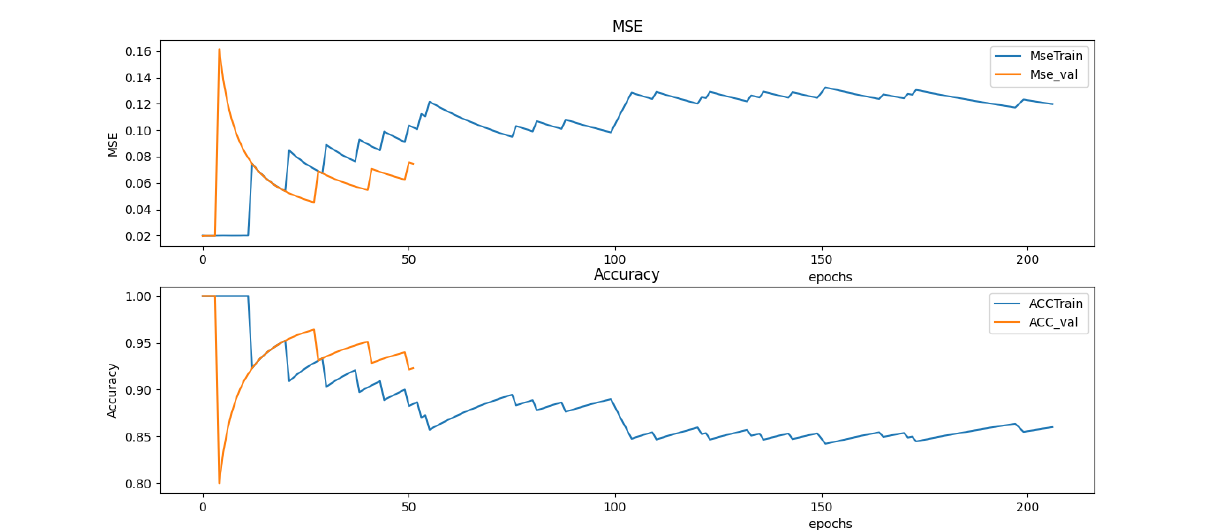
Figure 6. Machine learning algorithm shows increased accuracy and decreased MSE values over the first 50 training rounds (ie, epochs) for predicting PQOL through evaluation skills of HL ( a ccuracy: 0.92, MSE: